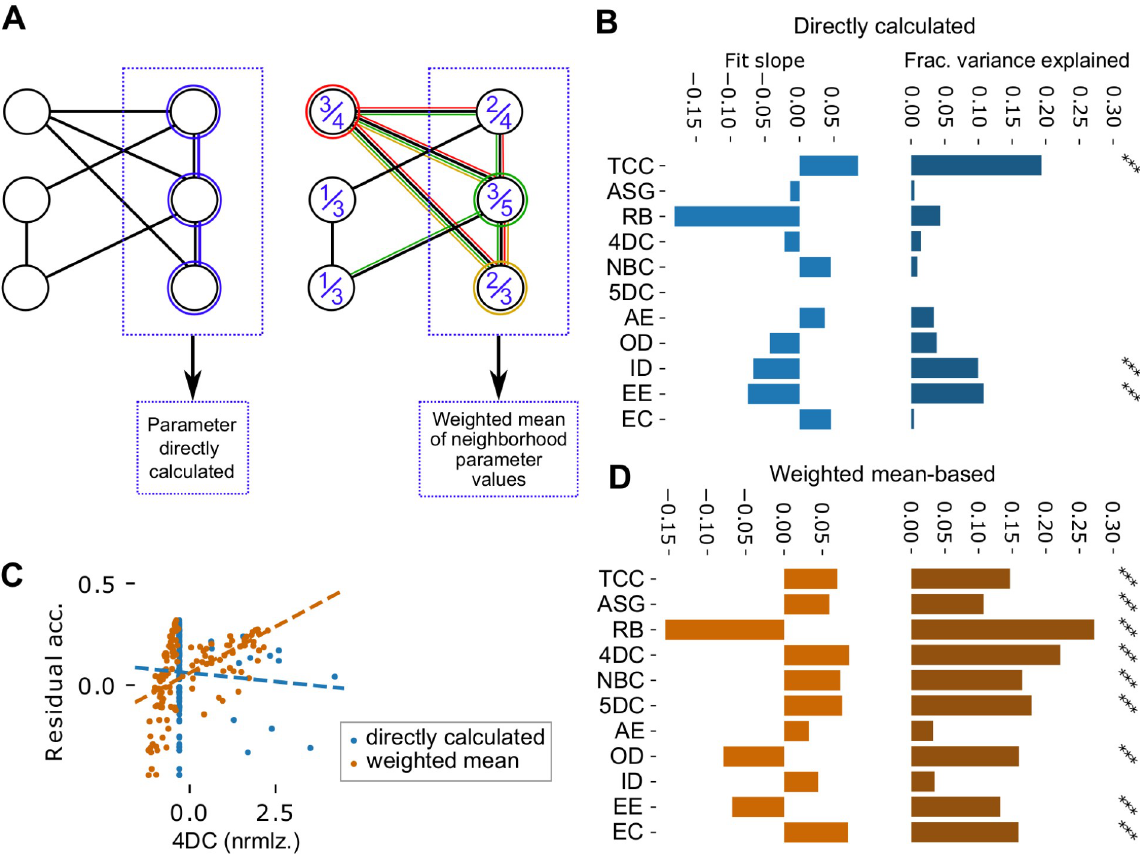
Fig 5. Topological parameters in volumetric samples. A: Two ways of calculating values for topological parameters in volumetric samples. Left: Values are calculated directly on the synaptic connectivity within the sample (blue neighborhood). Right: Generation of “synthetic” values of topological parameters that take the neighborhood structure of the sample into account: The size of the overlap of each possible neighborhood with the sample is calculated, then a weighted average of the parameter value for the N = 3 strongest overlapping neighborhoods is used (red, yellow, and green neighborhoods with relative overlaps of 3/4, 2/3, and 3/5 respectively). B: Left: Slopes of linear fits of residual accuracy against normalized parameter values that were directly calculated. Right: Fraction of variance of the residual accuracy that is explained by the linear models over a model that takes only the radius of the sample into account (see Methods). Black stars indicate Bonferroni-corrected significance ( ��� : p < 0.0001). Shorthand parameter names see Table 1. C: Comparing directly calculated parameter values (blue) to weighted mean-based, “synthetic” values of the fourth density coefficient. D: As in B, but for synthetic values of topological